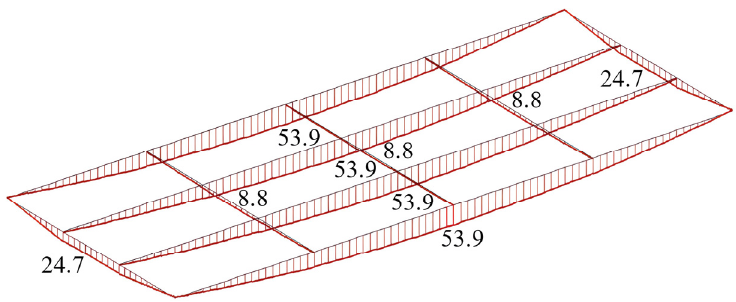
Figure 3. Design diagram of the module at loading Diagram II (kN).